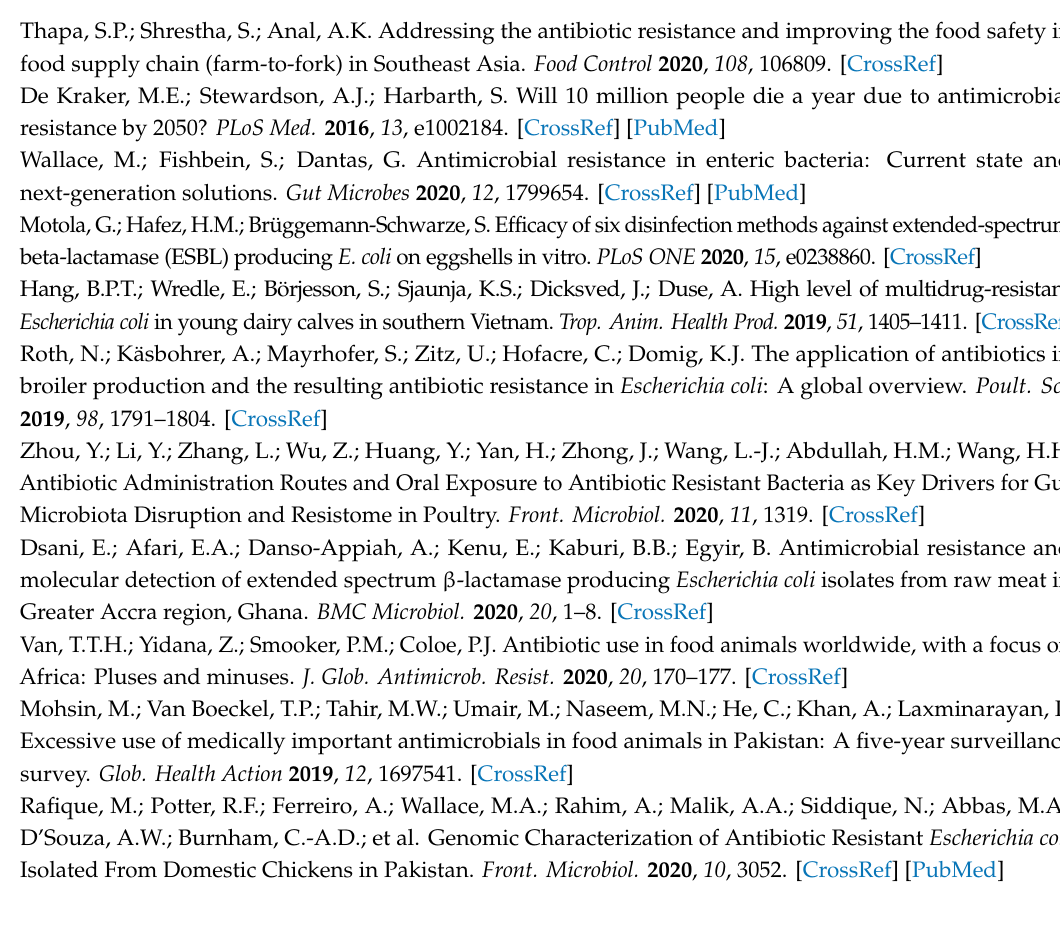
Table S1: Spectrum of antibiotics used in the selected poultry farms for therapeutic and growth promotion purposes, Table S2: Screening of E. coli infected samples among various poultry